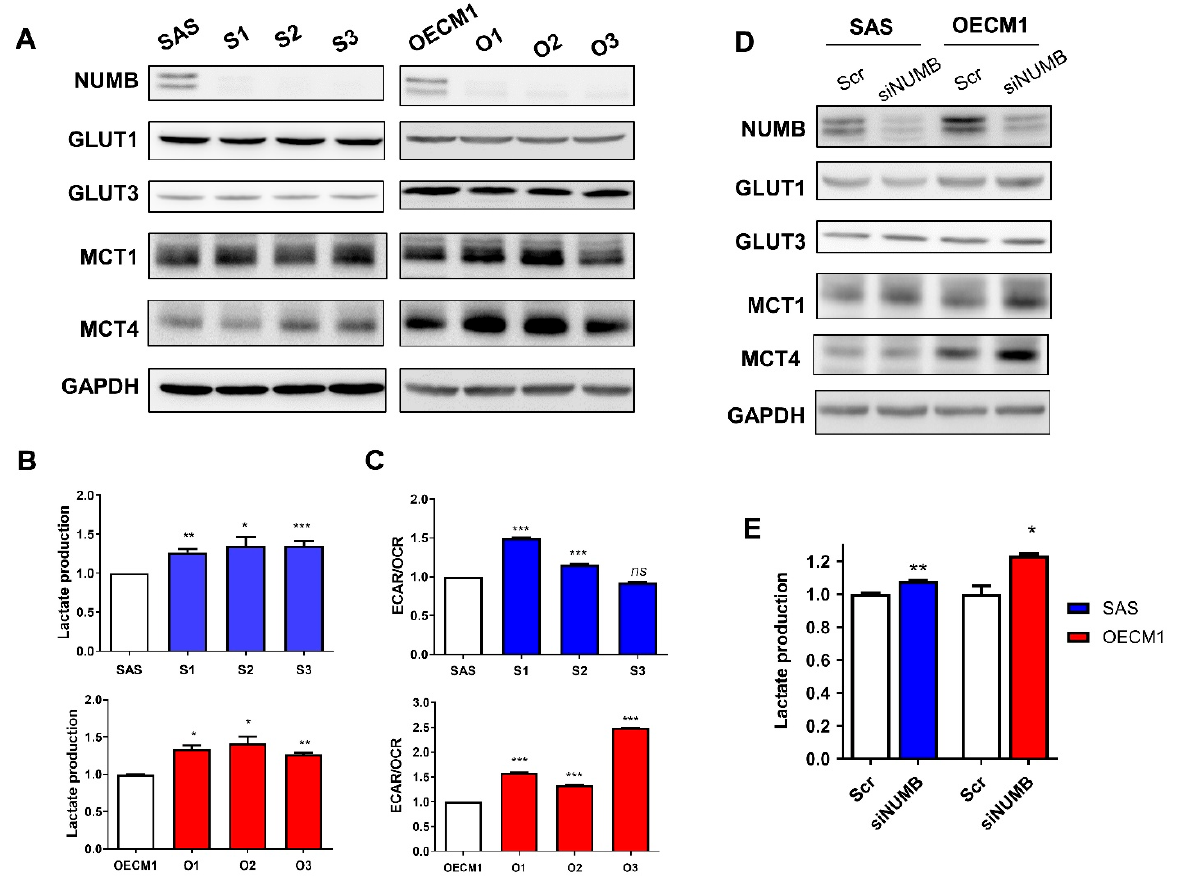
Figure 4. NUMB deletion or knockdown increases the expression of MCT1/MCT4 and glycolysis in OSCC cells. ( A , D ) Western blot analysis of knockout subclones and knockdown cells. There was a general tendency towards increased MCT1 and MCT4 expression in NUMB -deleted or NUMB-knockdown SAS and OECM1 cells. The expression of GLUT1 and GLUT3 was not changed. ( B , E ) Lactate production assay of knockout subclones and knockdown cells. The NUMB- deleted subclones and knockdown cells exhibited increased lactate production. ( C ) The anaerobic respiration shown by the ECAR/OCR ratio, which was measured by Seahorse flux analysis, increased in most NUMB knockout subclones. Scr, scramble oligonucleotide. ns , not significant; *, p < 0.05; **, p < 0.01; ***, p < 0.001.